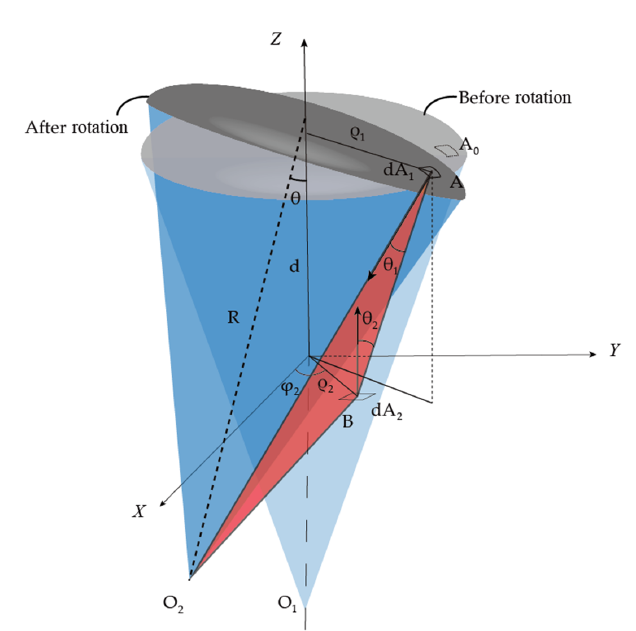
dA dA and an infinitesimal de ‐ Figure 3. Geometrical configuration of a spherical cap segment , Figure 3. Geometrical configuration of a spherical cap segment dA 0 ,dA 1 and an infinitesimal detector 0 1 dA at the positions of A tector surface , A and B. surface dA 2 at the positions of A 0 , A and 2 0